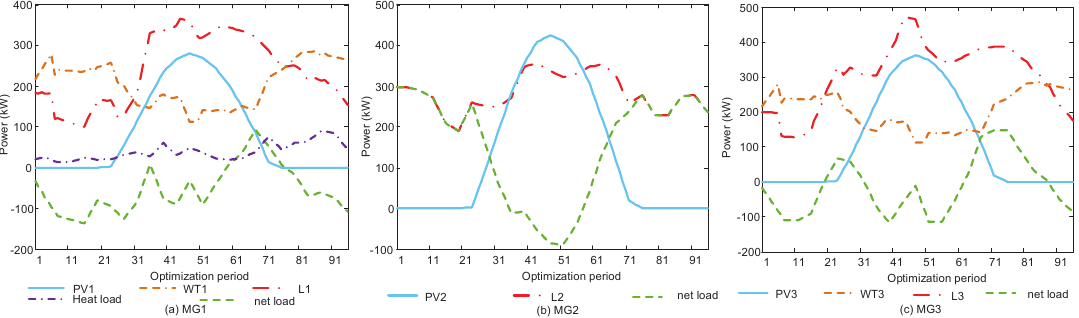
Figure 21. The PV power, WT power and load power in each MG in Scenario 2 (( a ) MG1; ( b ) MG2; ( c )